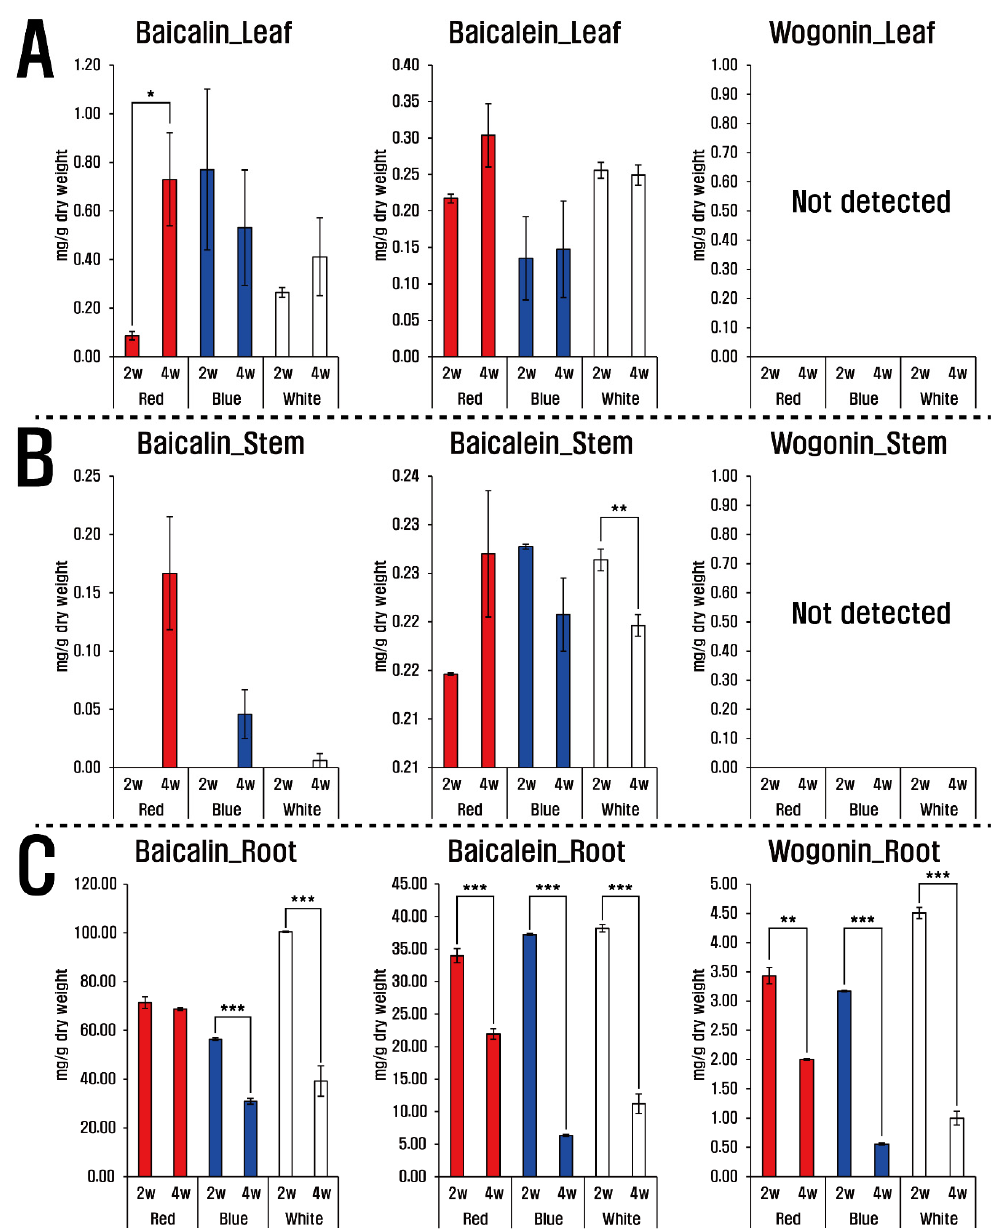
Figure 1. Flavone contents of the leaf ( A ), stem ( B ), and root ( C ) of S . baicalensis seedlings grown under LED treatment of varying duration. 2 w and 4 w indicate 2 weeks and 4 weeks, respectively ( t -test, * p < 0.05, ** p < 0.01, *** p < 0.005). 2.2. Metabolite-Specific Profiling of Root, Stem, and Leaf of S. baicalensis Treated with Different LED Light Sources GC-TOFMS was used to detect 50 metabolites (amino acids, sugars, sugar alcohols, organic acids, phenolic acids, and amines) in the roots, stems, and leaves of S . baicalensis seedlings treated with different LED light sources (red, blue, and white). In leaves and